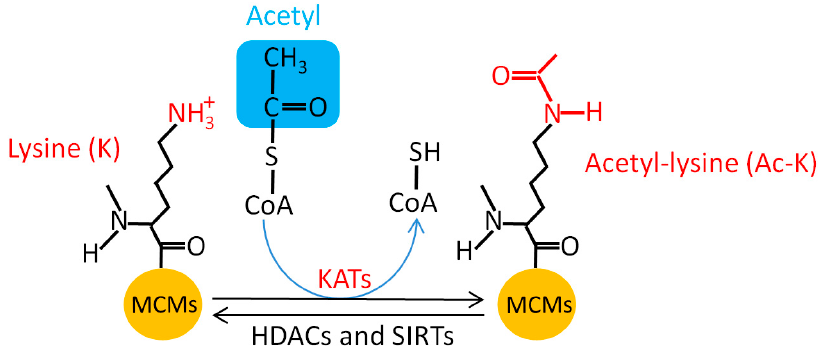
Figure 6. MCM acetylation. KATs, lysine acetyltransferases; HDACs, histone deacetylases; SIRTs, nicotinamide adenine dinucleotide (NAD)-dependent protein deacetylase sirtuins. Table 7. MCM acetylation in human cancer cells.